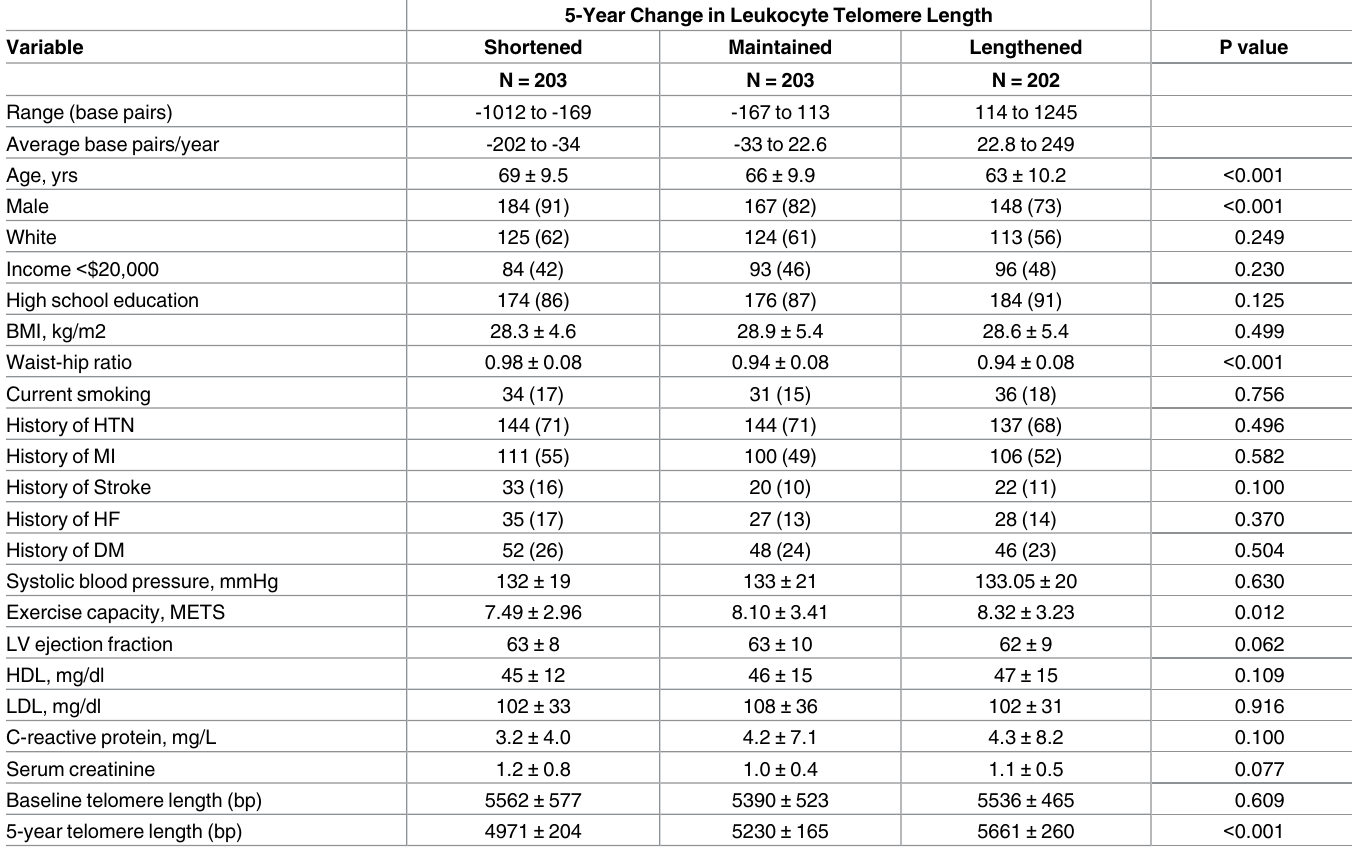
Table 1. Characteristics of participants by change in telomere length during the previous 5 years *